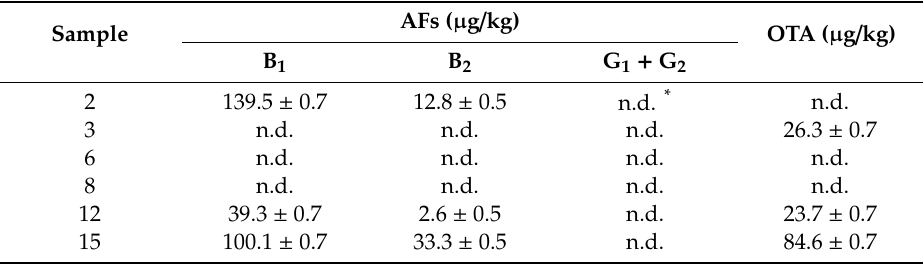
Table 5. AF concentration on dried chili and chili